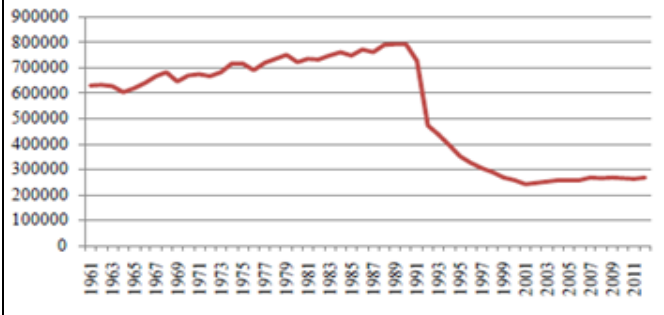
Figura 2: Evolución de la producción de lana en Europa, en toneladas (1990-2012). Fuente: